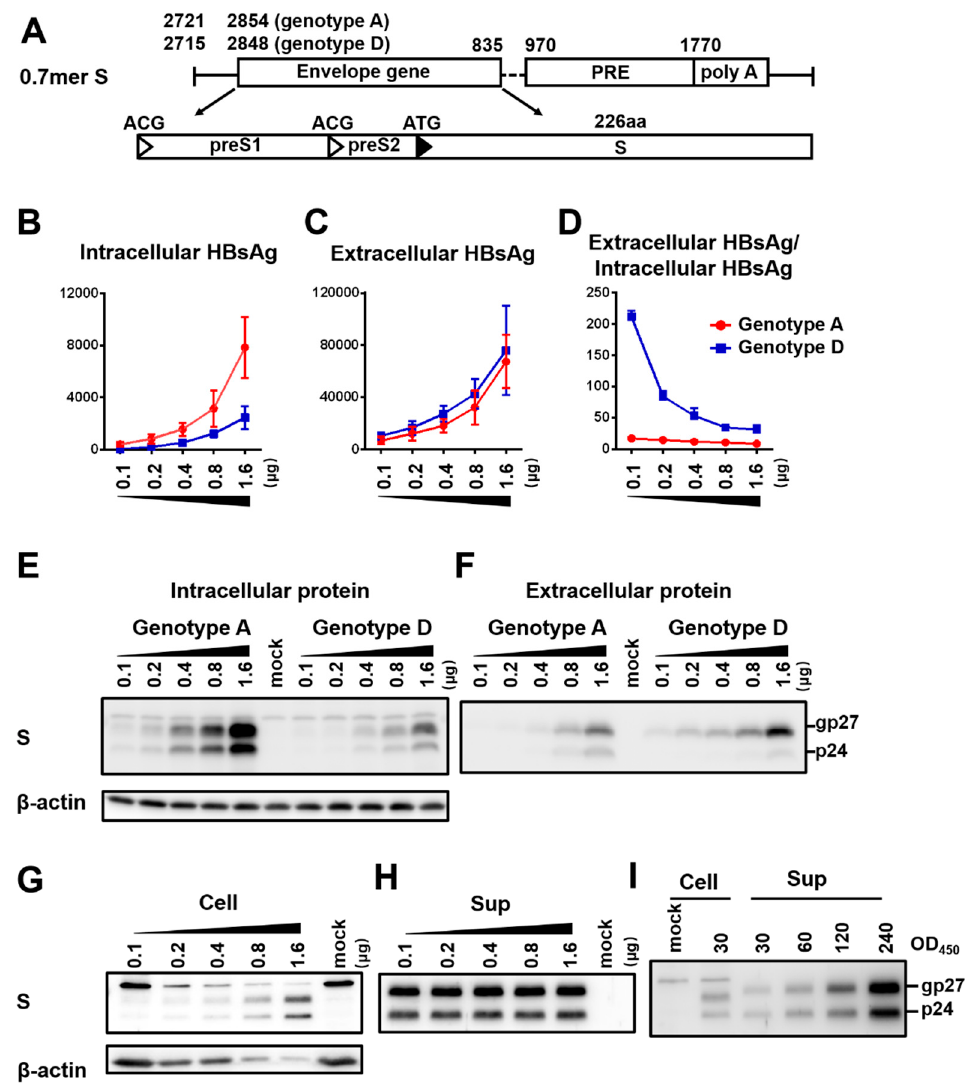
Figure 5. Impact of DNA dosage and viral genotype on S protein expression and HBsAg secretion from 0.7mer S protein construct. ( A ) The 0.7mer S construct was derived from 0.7mer L / M / S construct by mutating the preS1 and preS2 ATG codons into ACG. ( B – F ) Huh7 cells in 6-well plates were transfected with indicated amount of 0.7mer S protein construct of genotype A (geno5.4) or genotype D (geno1.2). Cells and culture supernatant were harvested four days later. ( B , C ) Total amount of HBsAg (OD 450 ) from cell lysate ( B ) and culture supernatant ( C ). Data were averaged from three independent transfection experiments. ( D ) Calculated ratio of extracellular / intracellular HBsAg. ( E , F ) Western blot analysis of intracellular ( E ) and extracellular ( F ) S protein from same volume of cell lysate or culture supernatant. β -actin served as an intracellular loading control. ( G , H ) Loading with equal OD 450 values of HBsAg from different doses of 0.7mer S construct of geno5.4 transfected. The OD 450 values were 30 for cell lysate ( G ) and 300 for culture supernatant ( H ). β -actin served as loading control for cell lysate. ( I ) Comparison of S protein from 30 OD 450 values of HBsAg from cell lysate with 30–240 OD 450 values of HBsAg from culture supernatant. Huh7 cells transfected with 1.6 μ g of geno5.4 were the source of cell lysate and culture supernatant.